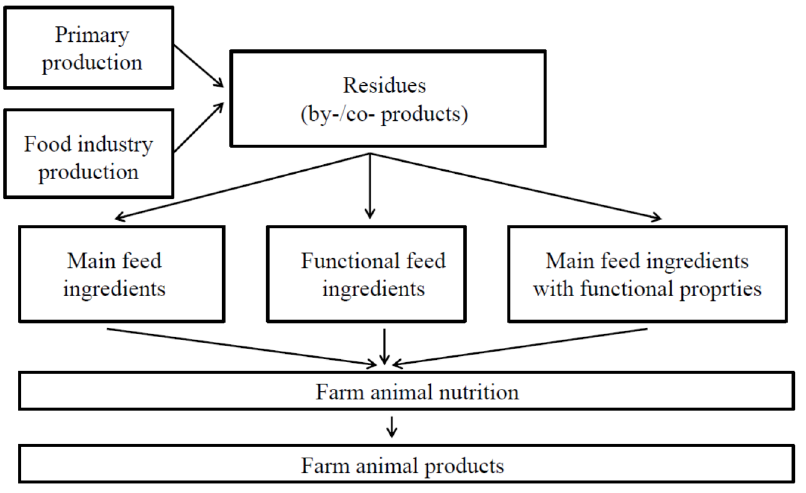
Figure 1. Simplified schematic presentation of the food–feed–food